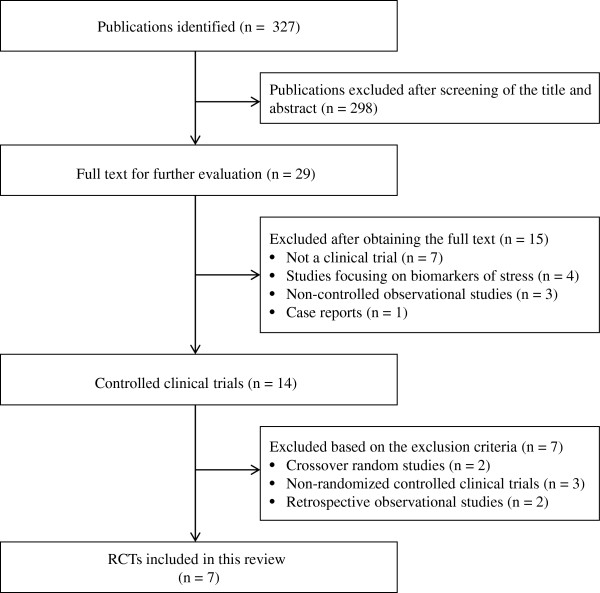
Selection process for included studies.